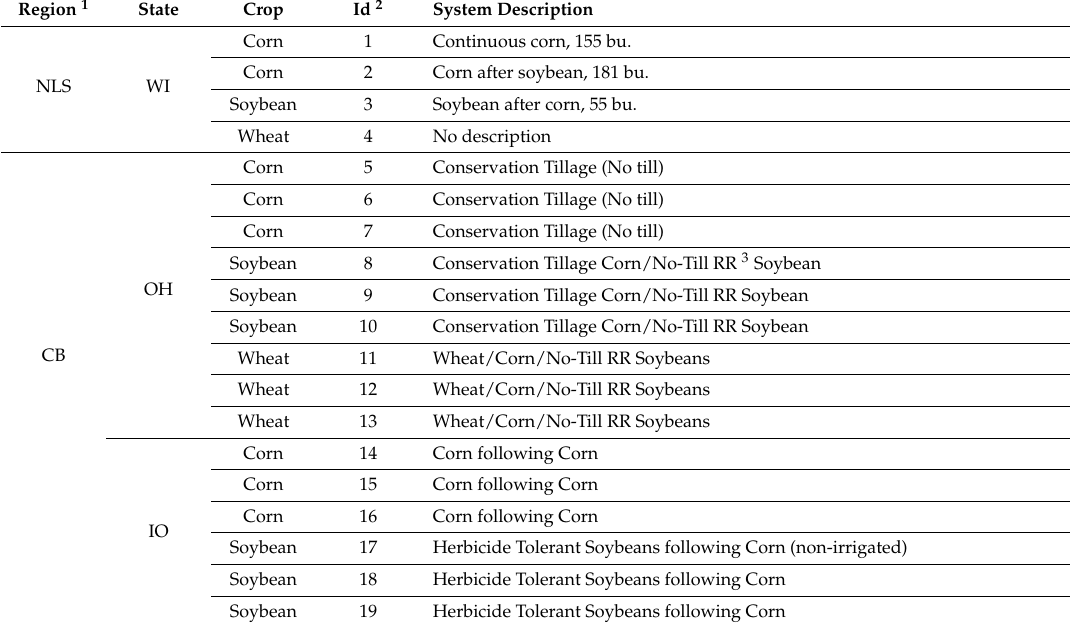
Table A1. Crop systems in different regions and states of the continental United States *. Region